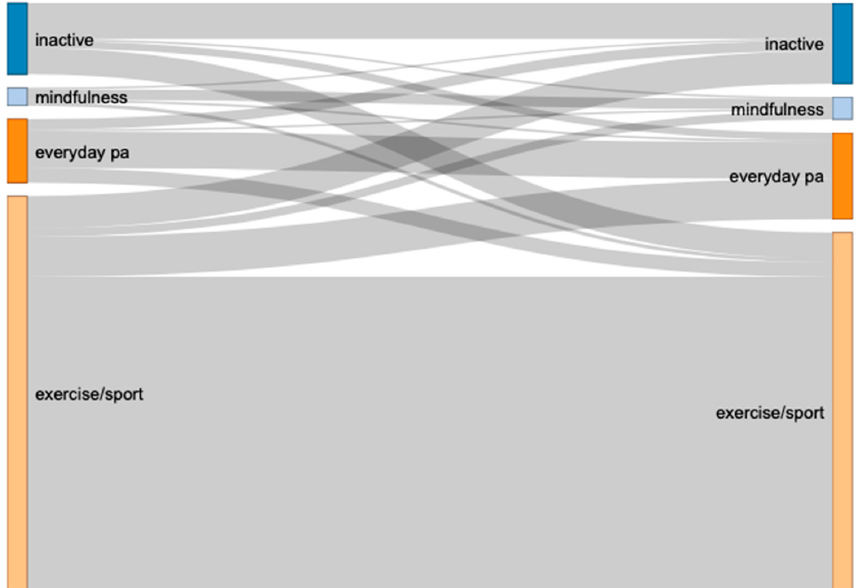
Figure 2. Changes in exercise types (broad category). Note that ‘before COVID ‐ 19’ is depicted on the left and ‘during the initial COVID ‐ 19 lockdown’ on the right side.